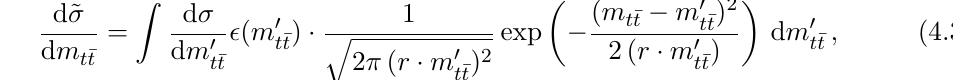
Figure 7 . E(cid:14)ciency of the event selection as a function of the parton-level invariant mass m computed with MC samples for the SM gg ! t (cid:22) t background, the resonant BSM contribution, and the interference. Event weights representing the e(cid:14)ciency of lepton identi(cid:12)cation and b -tagging are not